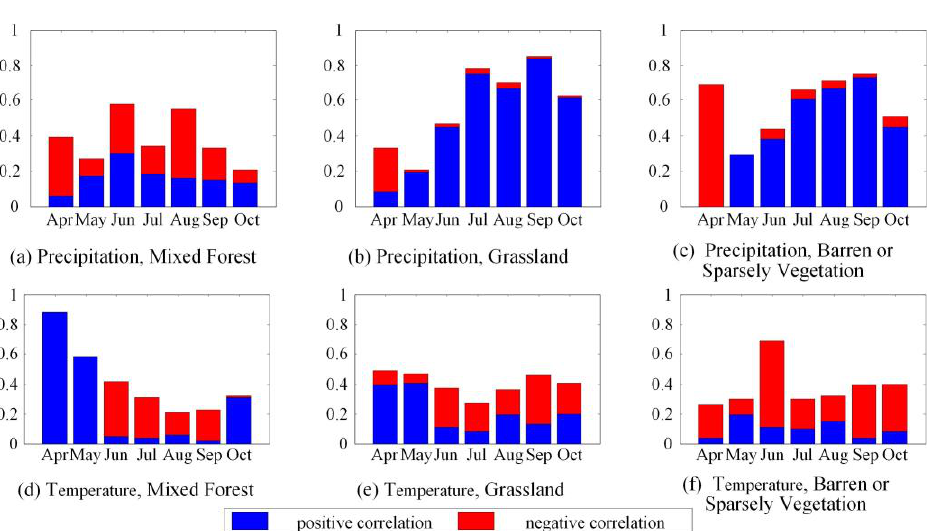
Figure 16. The statistical results of the percentage of significant pixels using linear regression of different types of vegetation and precipitation/temperature in different months.